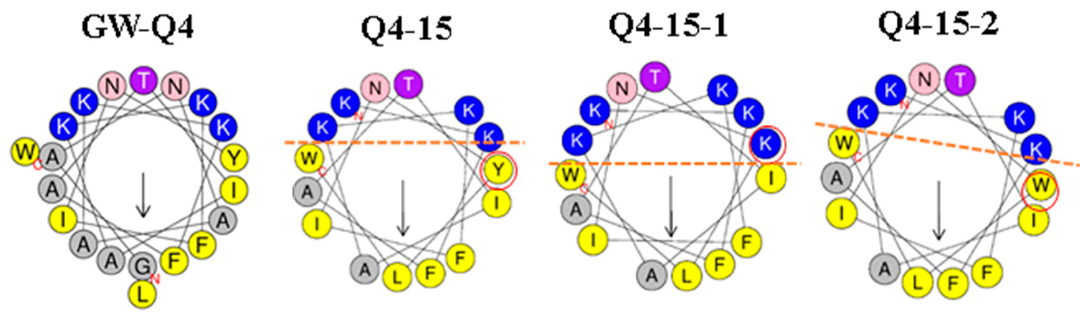
a Boldface type indicates amino acid residues truncated or substituted in the Q4 derivatives. b Hy- drophobicity was calculated using the consensus value for each amino acid residue as described [23].